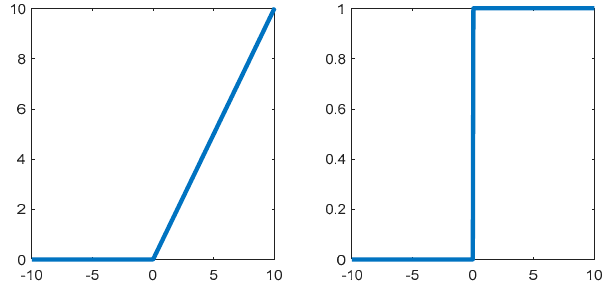
Figure 6. ReLU function and its gradient map.